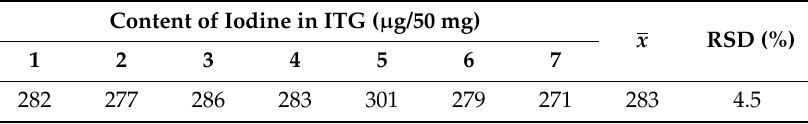
Table 4. Results of the repeatability experiment on ITG.